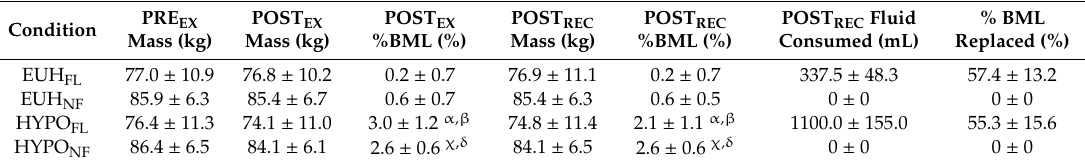
Figure 3. Changes in ( A ) rectal temperature and ( B ) heart rate during exercise and recovery in EUH FL , EUH NF , HYPO FL , and HYPO NF groups. EUH FL = minimized fluid losses during exercise and remaining losses replaced during recovery; EUH NF = minimized fluid losses during exercise and did not replace losses during recovery; HYPO FL = fluid restricted during exercise and losses replaced during recovery; HYPO NF = fluid restricted during exercise and losses not replaced during recovery. Table 1. Body mass changes by condition.